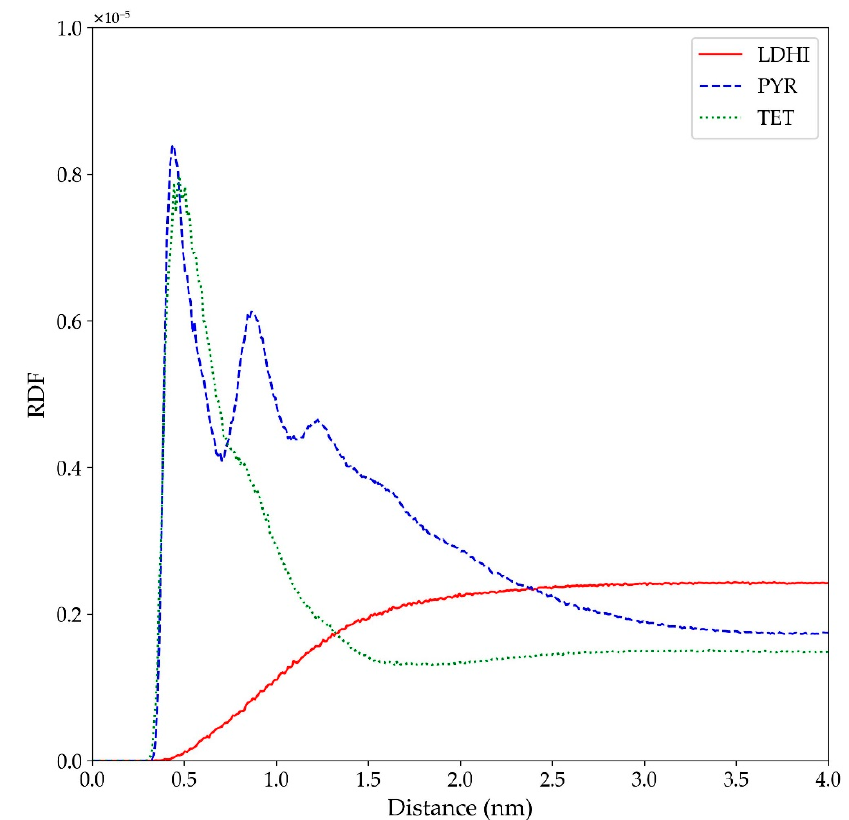
Figure 10. Radial distribution function among the rings of different monomer units (referred to their ring centers in each unit) for the large nanosphere models (lDHI: red; PYR: blue; TET: green) in implicit solvent.